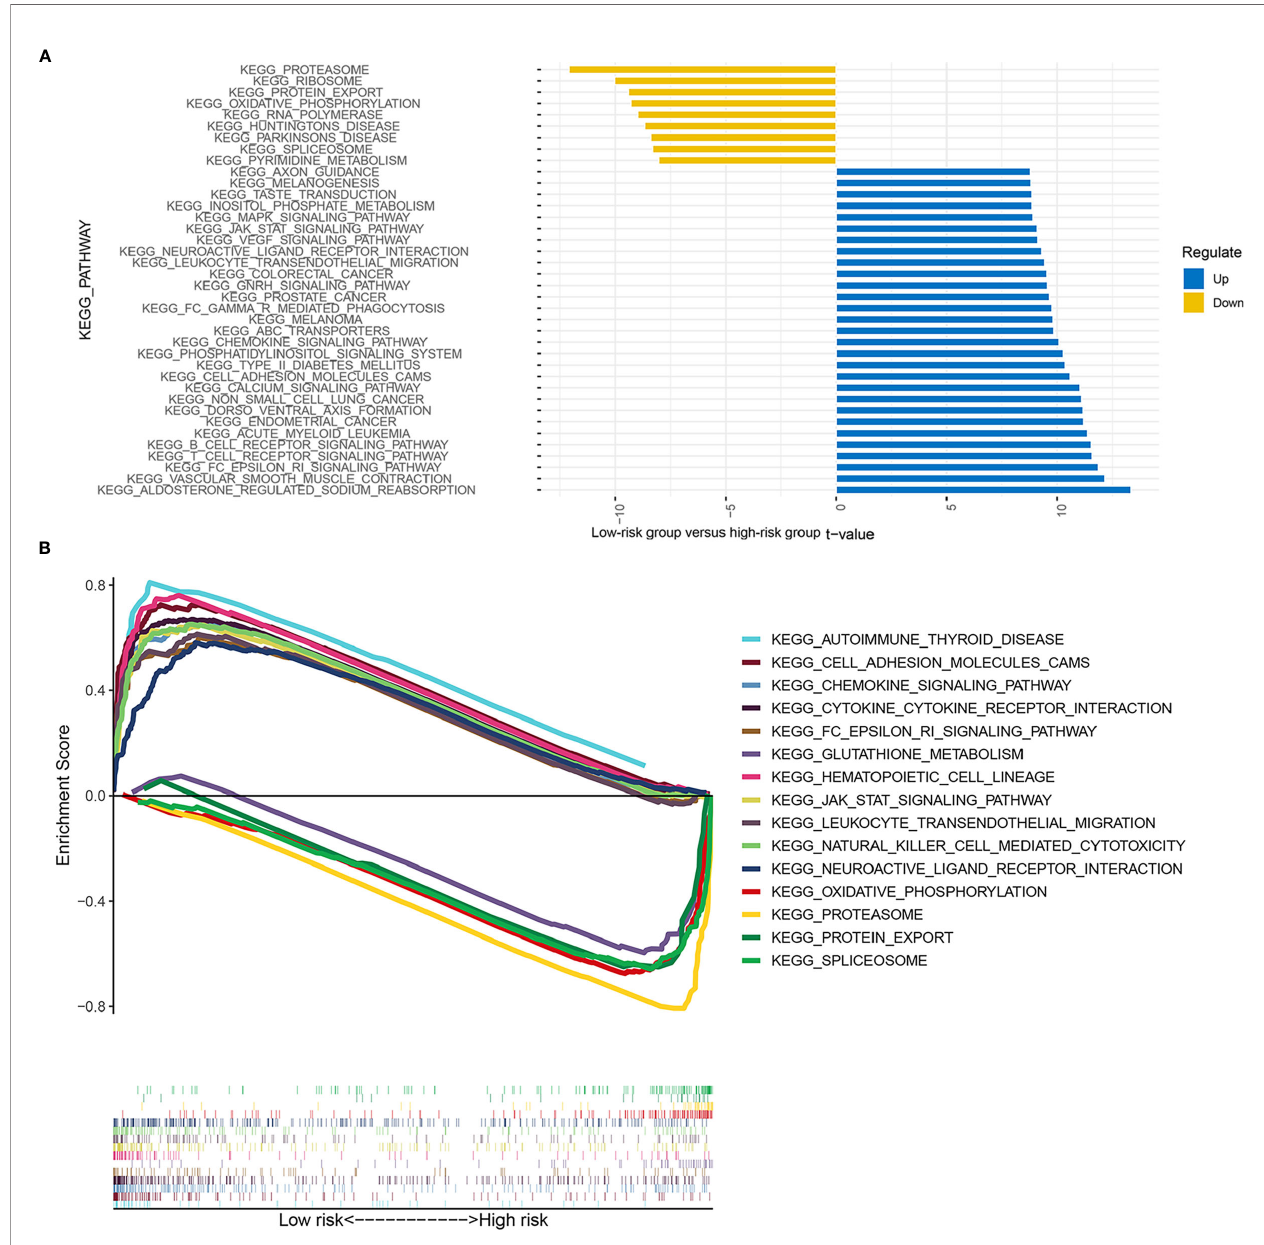
FIGURE 9 | Enrichment signaling pathways of different risk groups. The pathway enrichment of gene set variation analysis (GSVA) between the low- and high-risk groups (A) . The pathway enrichment of gene set enrichment analysis (GSEA) between the low- and high-risk groups (B)